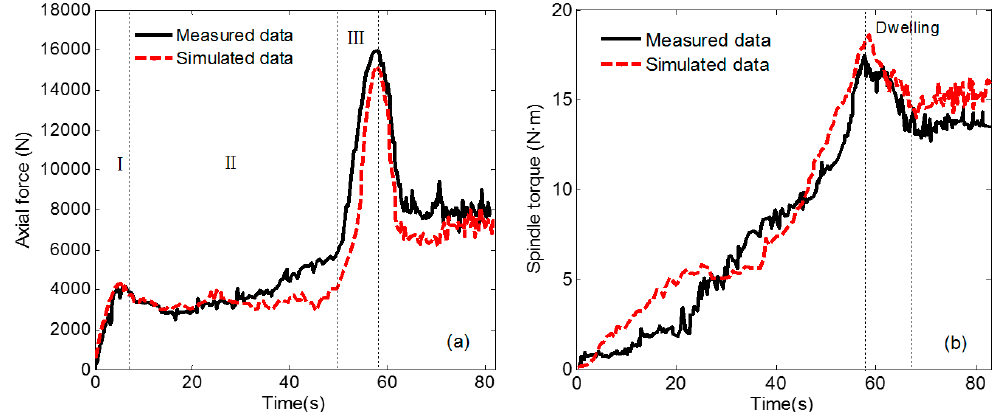
Figure 9. Comparison of axial force and torque data (Spindle Speed 900 rpm). ( a ) Validation of axial force; ( b ) validation of spindle torque.